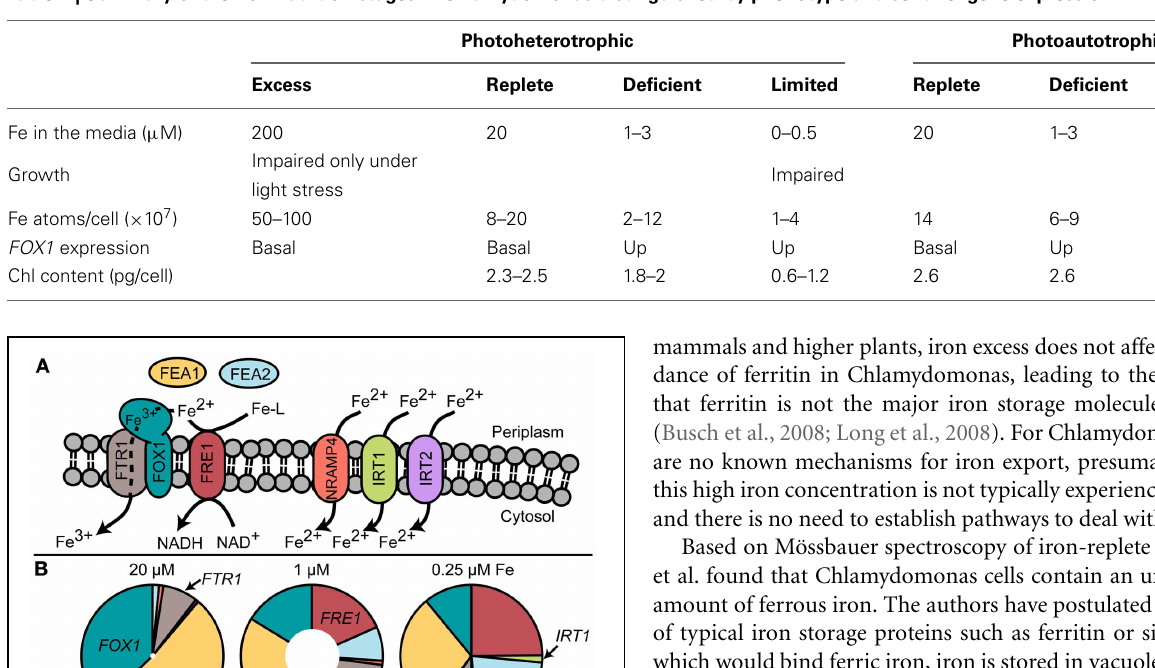
Table 1 | Summary of the iron nutrition stages in Chlamydomonas distinguished by phenotype and sentinel gene expression.